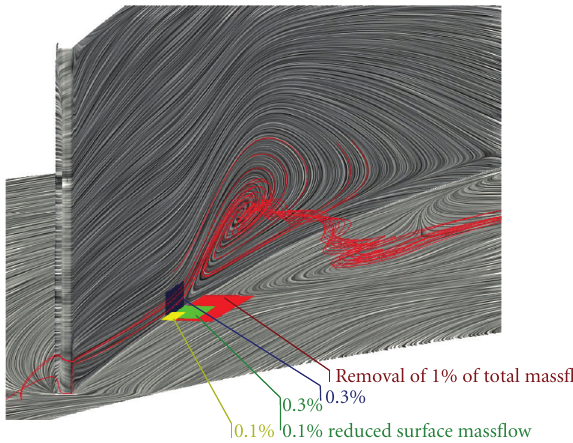
Figure 16: Locations of suction slots and percentage of removed massflow; operating point C.